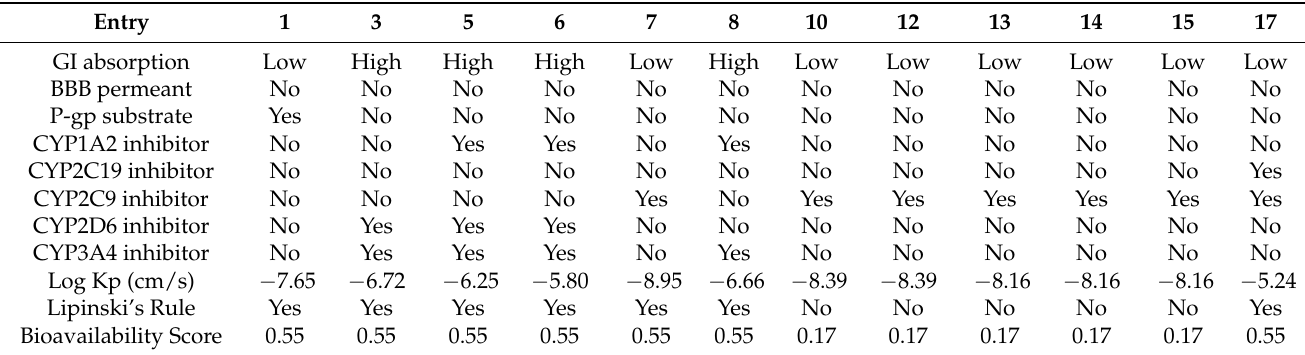
Table 4. Physicochemical properties, pharmacokinetics and drug-likeness of identified compounds according to SwissADME software.